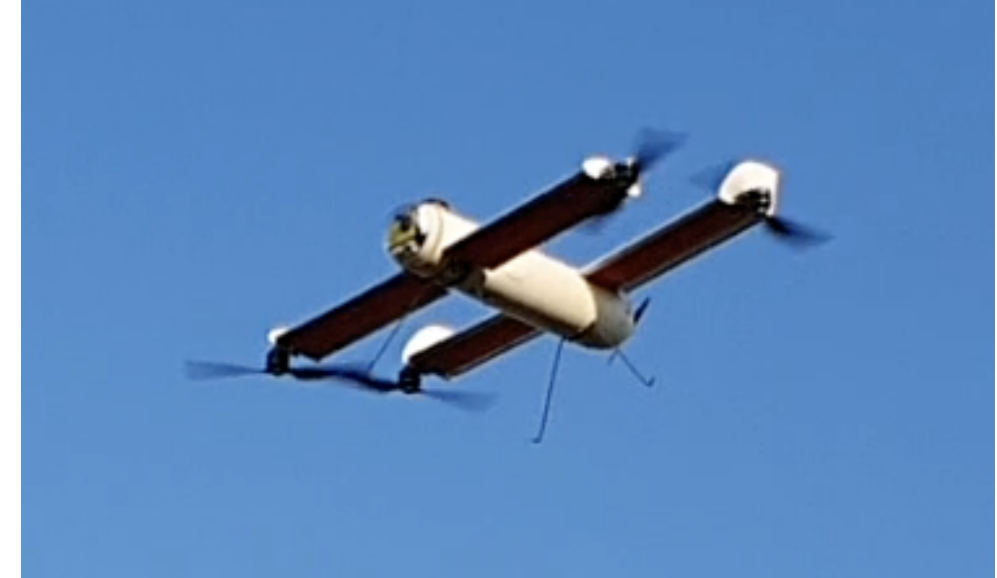
Figure 2. The Elka1Q drone in one of its test flights.